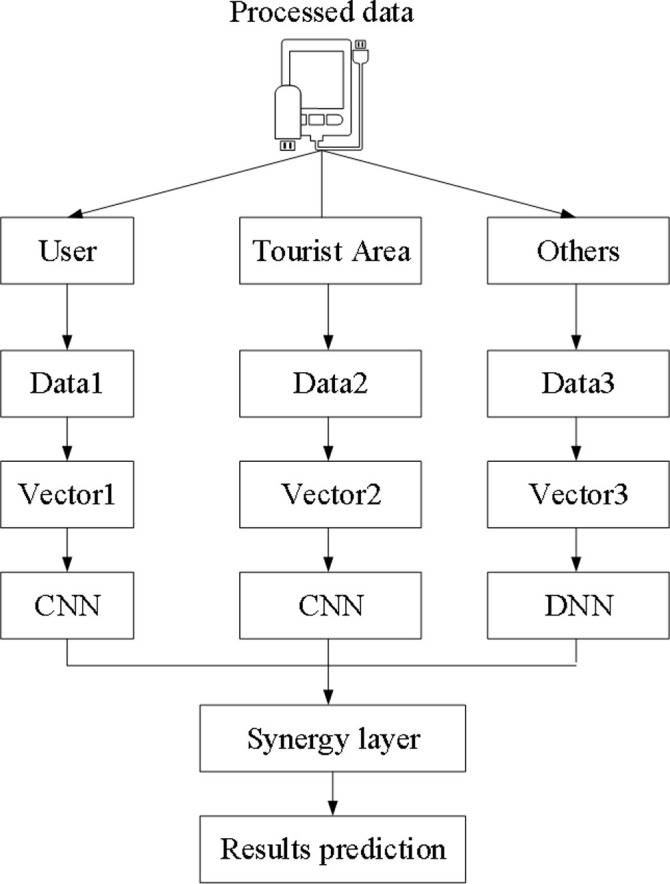
Model structure of word embedding technology.